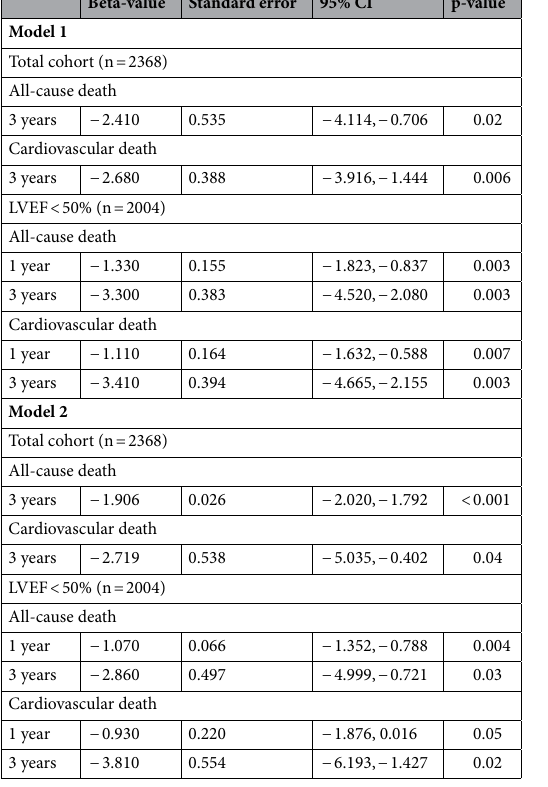
Table 3. Data for periods of admission in multiple regression analyses. Model 1 : Quintiles of admission period, age, sex, left ventricle ejection fraction, NYHA class III-IV, and number of comorbidities (diabetes, hypertension, anaemia, atrial fibrillation or flutter, chronic obstructive pulmonary disease). Multiple regression was stepwise analysis. Model 2 : Quintiles of admission period and MAGGIC risk score at 1 and 3